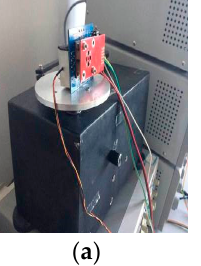
Figure 12. ( a ) photograph of the rate table with the proposed rotational gyroscope and a Micro-electromechanical Systems (MEMS) quartz vibratory gyroscope on it for dynamic characteristic test; ( b ) impulse responses of the proposed rotational gyroscope and a MEMS quartz vibratory gyroscope.